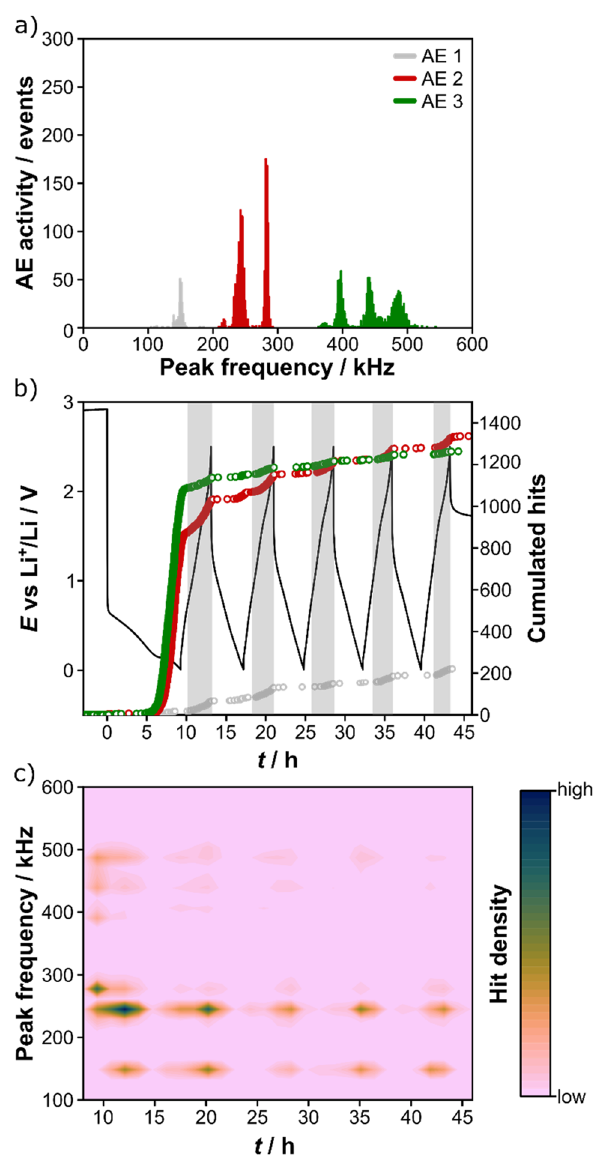
Figure 4. ( a ) Peak-frequency histogram of AE signals detected during the first five cycles. The signals were separated and clustered into different groups based on their peak frequency. ( b ) Voltage profile (black) and the corresponding cumulated hits for the different peak-frequency ranges [same color scheme as in ( a )]. Major acoustic activity in the delithiation cycles is highlighted for clarity. ( c ) Contour plot of acoustic activity (hit density) as a function of time and peak frequency (starting from the initial delithiation cycle at 0.01 V vs Li +